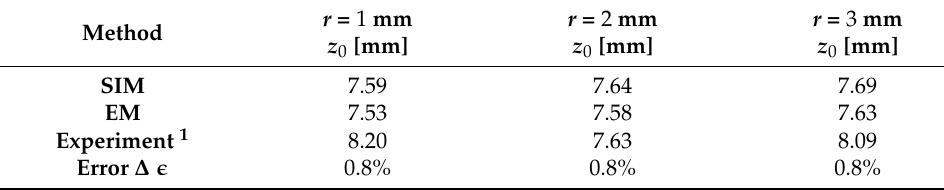
Table 3. The impact of the rod’s radius ( r ) on the PM’s equilibrium height.